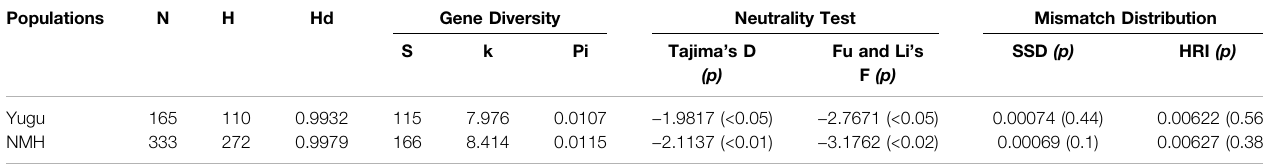
TABLE 2 | Diversity indexes and neutrality tests for the studied Yugu ethnic group and NMH population. Populations